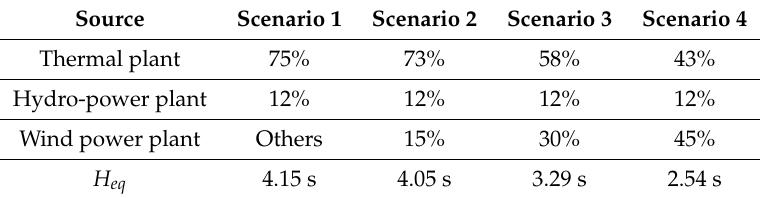
Table 2. Capacity of each generating unit and total RES